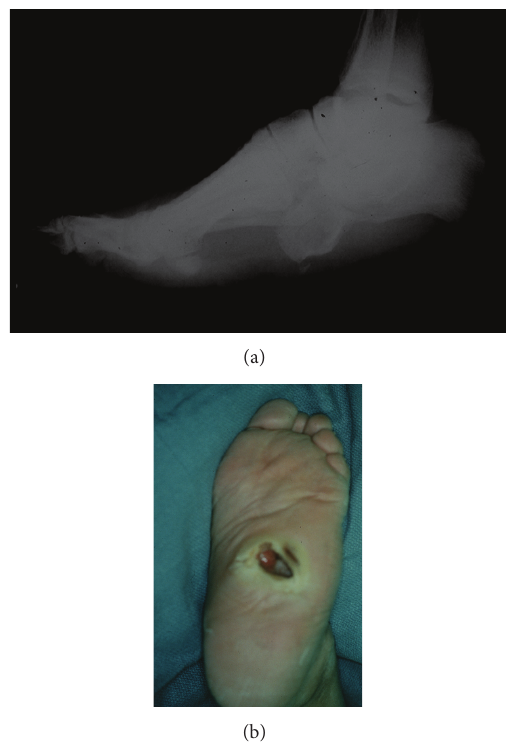
F 3: Rocker bottom foot deformity secondary to Charcot disease. (a) �-ray image lack of ankle joint dorsi�exion resulting in an increased load to the forefoot. is in turn leads to collapse of the tarsometatarsal joint, which is the focus point between the forefoot and hindfoot. e arch has collapsed and appears to be almost inverted. (b) Charcot foot with rocker bottom has increased involvement of Lisfranc